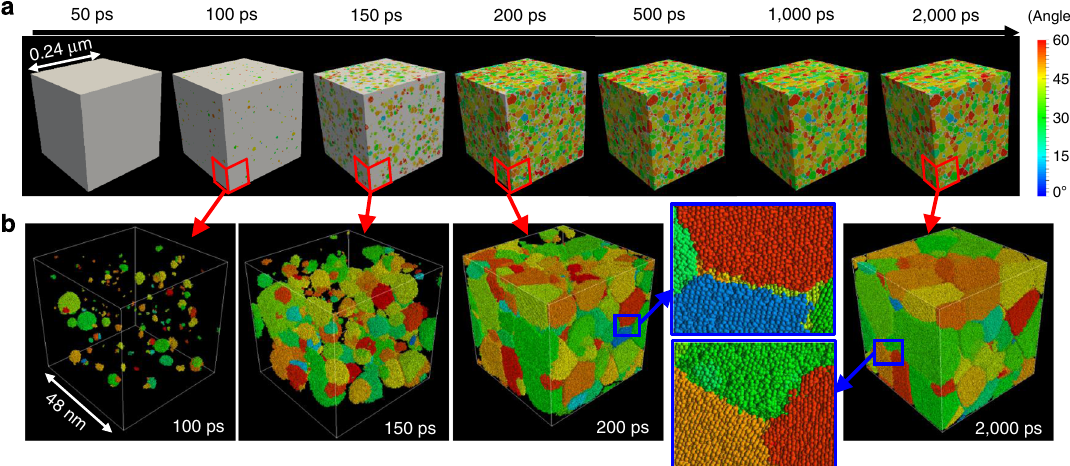
Fig. 1 Snapshots of the simulation cell during a 2,000 ps calculation for a temperature of 0.58 T m . a Whole simulation cell and b part of the simulation cell indicated by the red lines in a . All grains are coloured in accordance with the disorientation angle relative to the coordination axis. Areas of liquid and grain boundaries are coloured in white in a and are not shown in b . Inset fi gures represent enlarged views of the atomic con fi guration in the areas indicated by blue